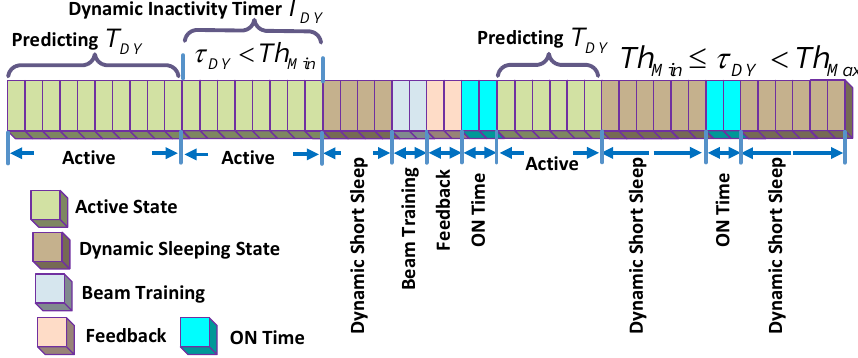
Figure 6. Timing diagram of AI-DRX based dynamic short sleep